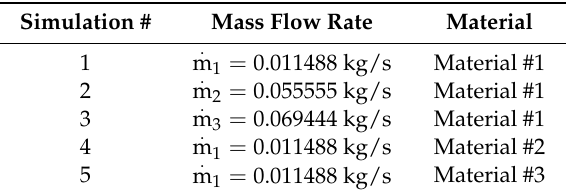
Table 2. Summary of simulations.